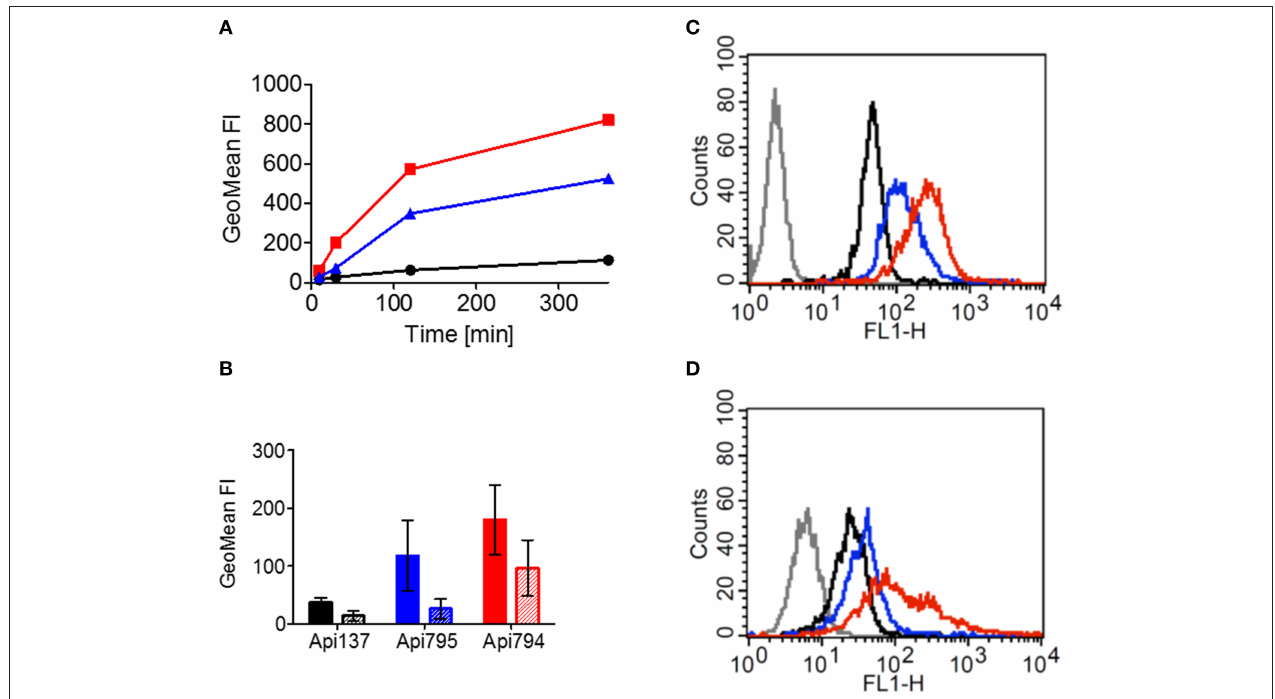
FIGURE 7 | Uptake of Cf-labeled Api137 (black), Api795 (blue), and Api794 (red) in HeLa cells determined by flow cytometry. (A) HeLa cells were incubated for the indicated times with Api137, Api795, or Api794 (40 µ mol/L). (B) HeLa cells were treated for 45 min without (filled bars) or with dynasore (0.2 mmol/L, striped bars) before they were treated with a peptide (40 µ mol/L) for 30 min. Cells not incubated with a peptide were used as controls (gray in histograms) without (C) or with dynasore (D)